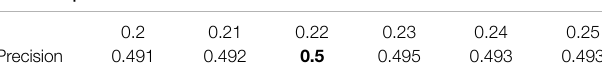
TABLE 3 | Precision values of NNP on different thresholds of WNT.